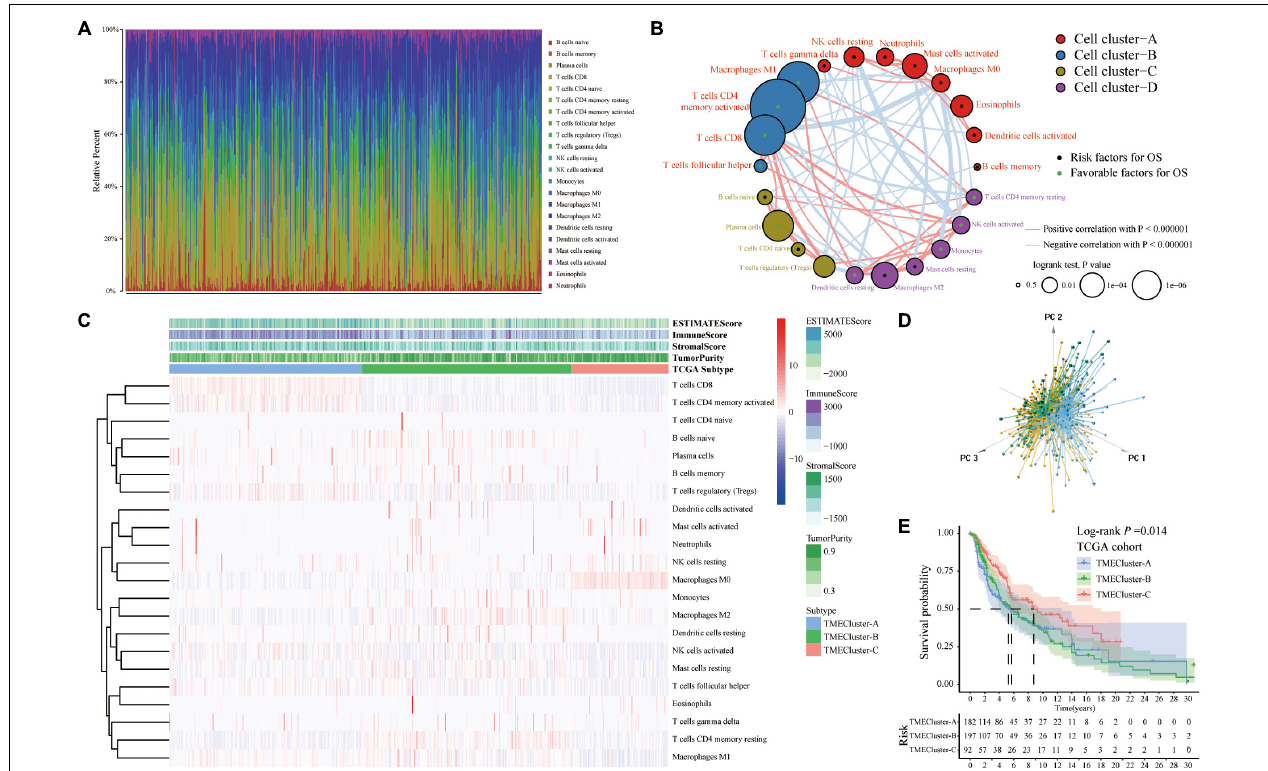
FIGURE 1 | Immune cellprotect infiltration in TCGA-SKCM database. (A) Histogram showing the infiltration of 22 different specific immune cells in each sample CIBERSORT. Different colors indicate different tumor-infiltrating immune cells. (B) The interaction between immune cells in TME in TCGA-SKCM. Cell cluster-A, red; Cell cluster-B, blue; Cell cluster-C, brown; Cell cluster-D, purple. The size of the circle represents the impact of each TME cell type on survival, and the log-rank test was used for analysis. The green part in the center of the circle indicates that the cell protects against overall survival, and the black indicates the risk to overall survival. The lines connecting TME cells represent cell interactions. The thickness of the line represents the correlation strength estimated by Spearman correlation analysis, in which positive correlation is represented by red and negative correlation is represented by blue. (C) Heatmap showing the infiltration of TIICs in 471 SKCM patients in TCGA database combined with the immune score. Unsupervised clustering grouping the samples into three major clusters. (D) The PCA of the gene expression profile distinguishes patients in the TME cluster-A, -B, and -C groups in TCGA-SKCM. The results can distinguish three different immune infiltration pattern samples (TME cluster-A: blue, TME cluster-B: yellow, TME cluster-C: green). (E) The Kaplan–Meier curve of the patient’s overall survival (OS) shows that TME infiltration is significantly related to the overall survival (Log-rank test, p =